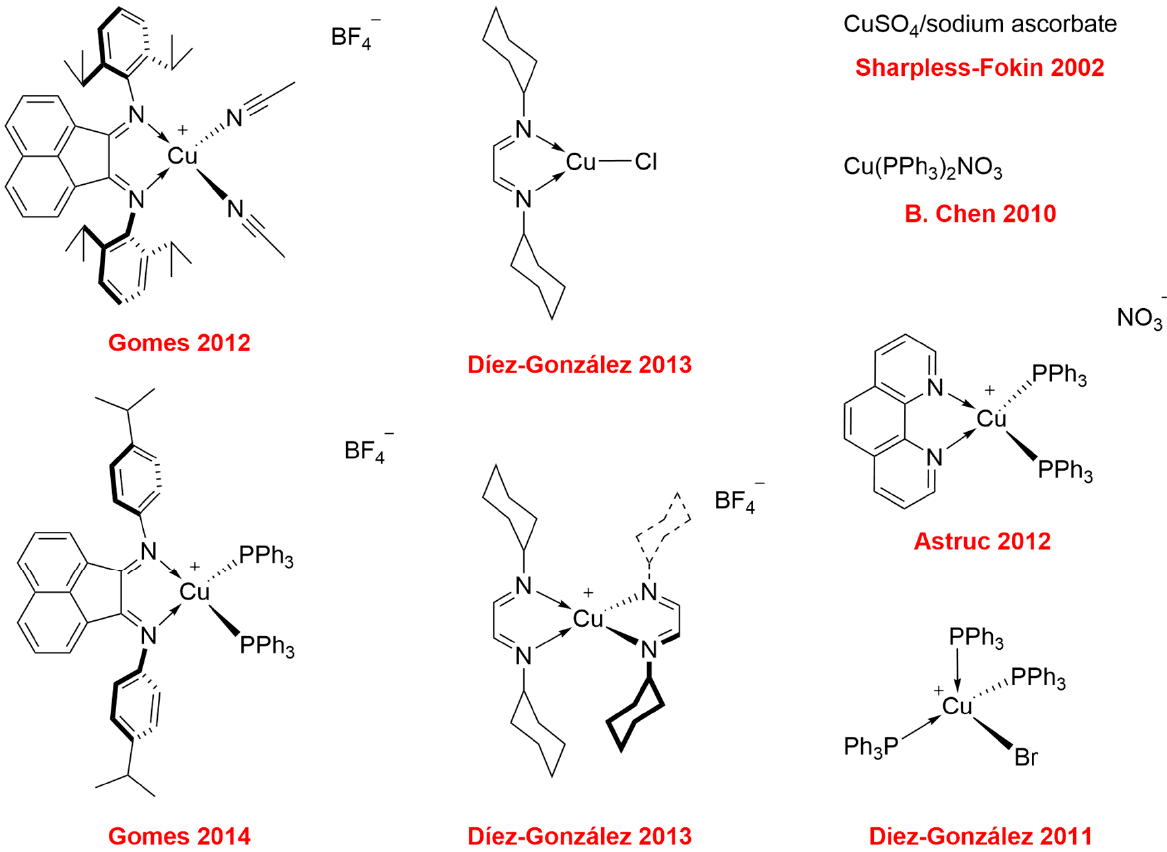
Figure 1. Examples of CuAAC’s copper(I) catalysts reported in the literature.